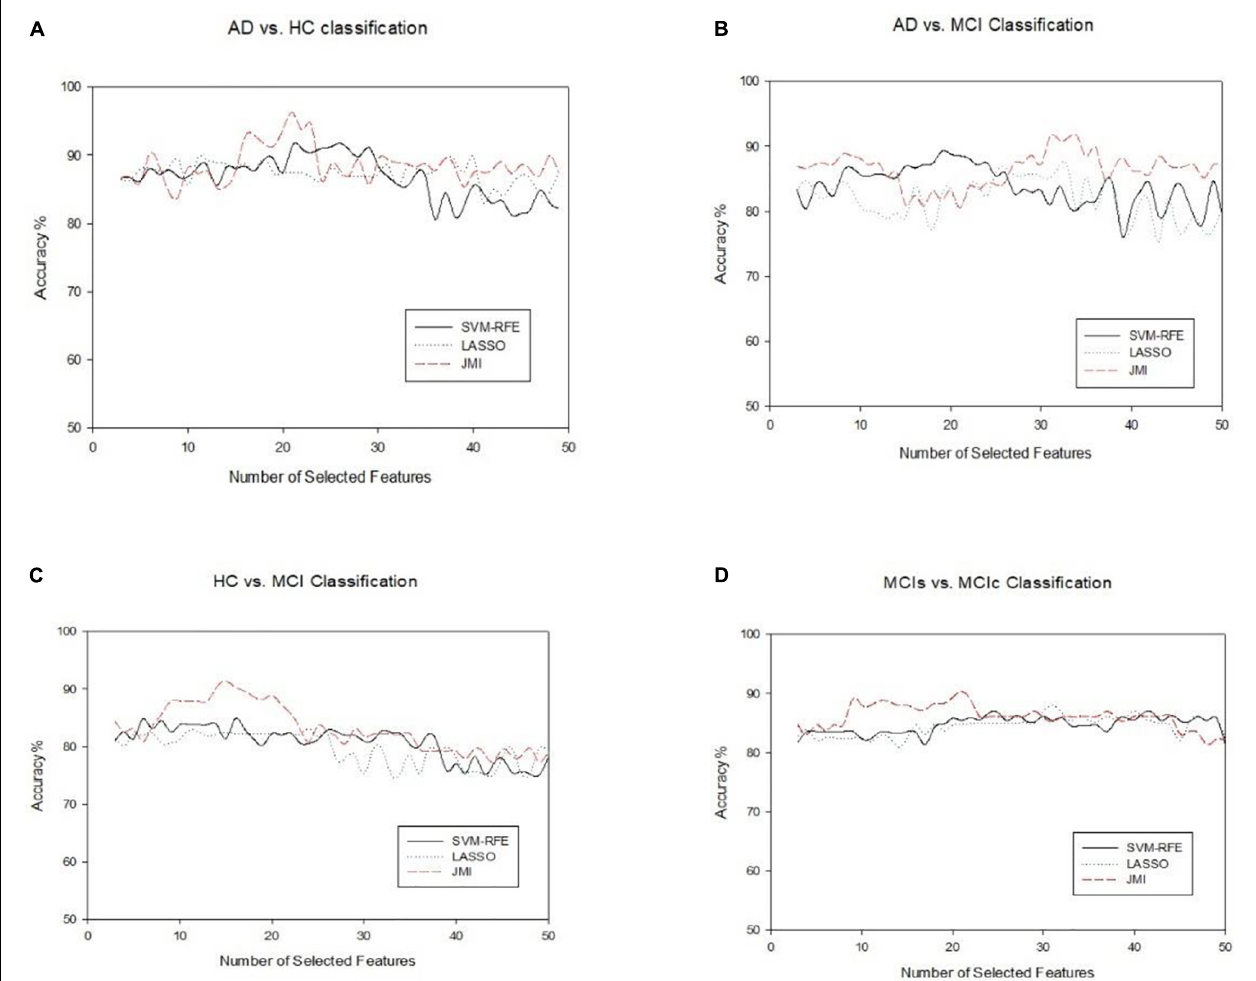
FIGURE 8 | An illustration of the performance of three feature selection algorithms for classifying four different groups on combined features vectors (A) AD vs. HC, (B) AD vs. MCI, (C) HC vs. MCI, and (D) MCIs vs. MCIc. The x -axis represents the number of selected features, while the y -axis represents the classification